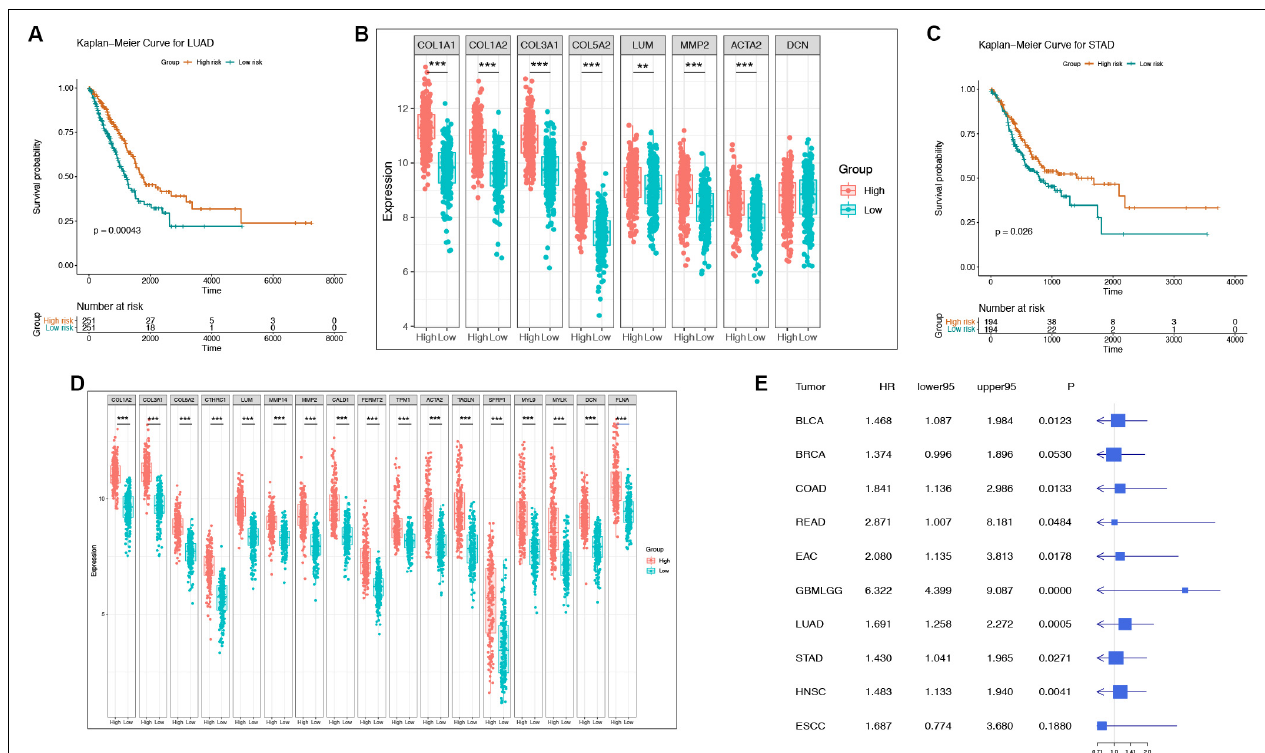
FIGURE 4 | The representative survival curve and forest plot of “off-track gene” risk scores for multiple cancers. (A–B) The survival curves and the gene expression intensity in the low risk group as well as in the high risk group of LUAD patients in TCGA datasets. * P < 0.05, ** P < 0.01, *** P < 0.001, and no stars for genes whose p -value is > 0.05. Box plots compare the difference of gene expression between risk groups using a t -test. (C–D) The survival curves and the gene expression intensity in the low risk group as well as in the high risk group of STAD patients in TCGA datasets. * P < 0.05, ** P < 0.01, *** P < 0.001, and no stars for genes whose p -value is > 0.05. Box plots compare the difference of gene expression between risk groups using a t -test. (E) Forest plot of “off-track genes” using data from multiple cancer cohorts in TCGA using a univariate cox repression model. The forest plot shows the HR, 95% confidence interval, and p- value for each type of